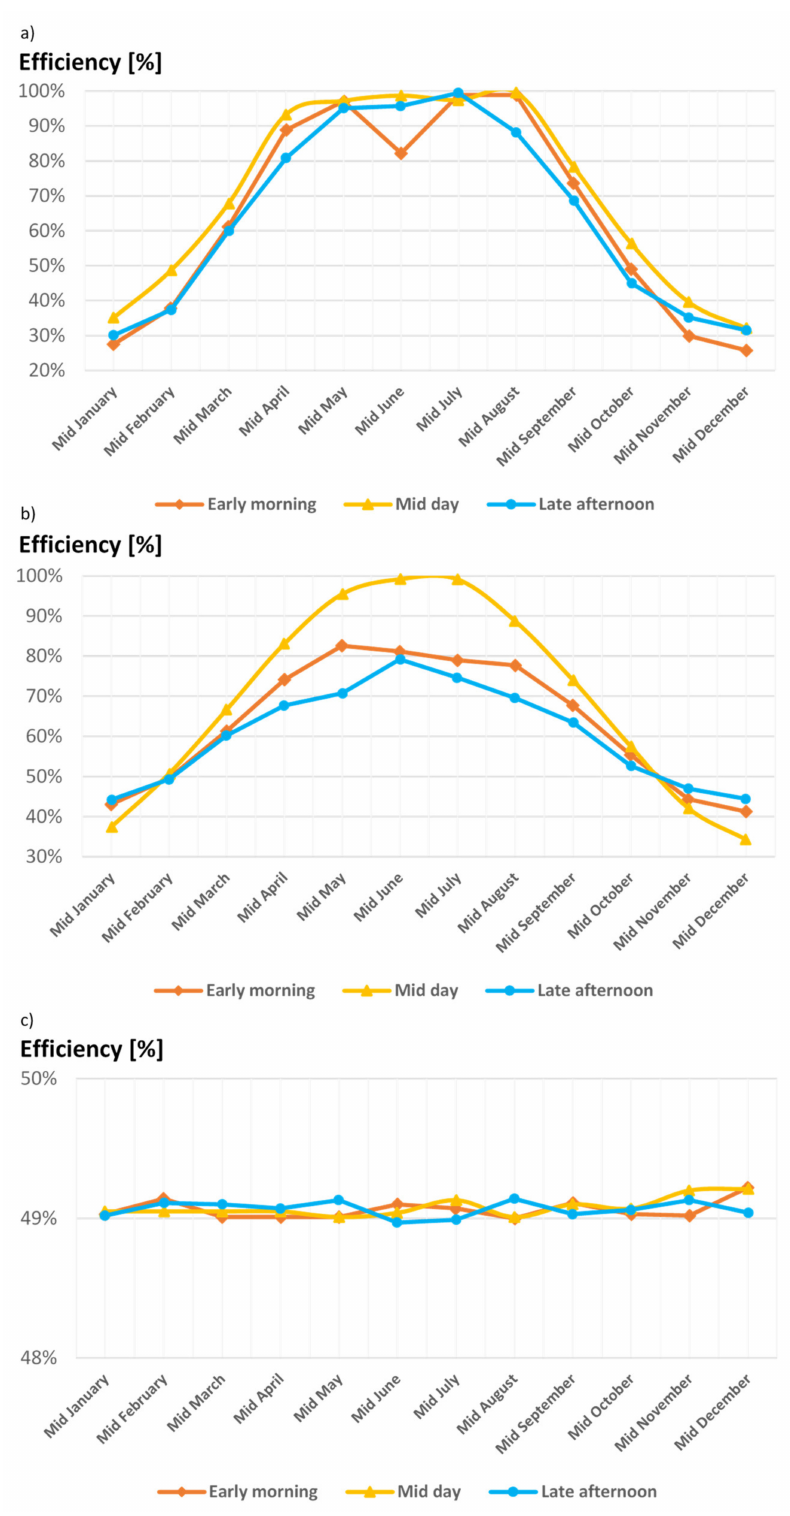
Figure 14. The efficiency of the daylight system for different times of the day during a year under different sky conditions: ( a ) CIE clear sky; ( b ) CIE intermediate sky; and ( c ) CIE overcast